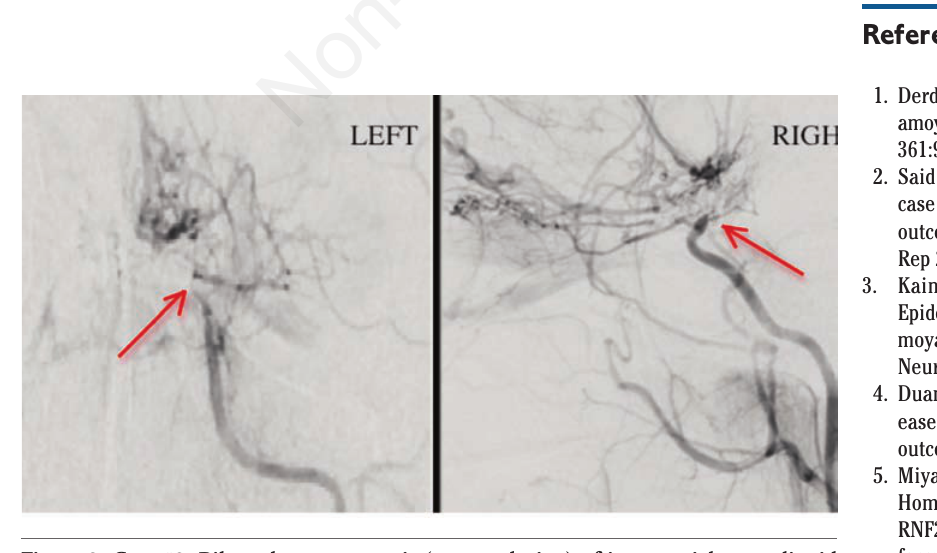
Figure 3. Case #2. Bilateral severe stenosis (near occlusion) of intracranial supraclinoid internal carotid arteries (left worse than right) with multiple transdural basilar collater- als consistent with moyamoya angiographic